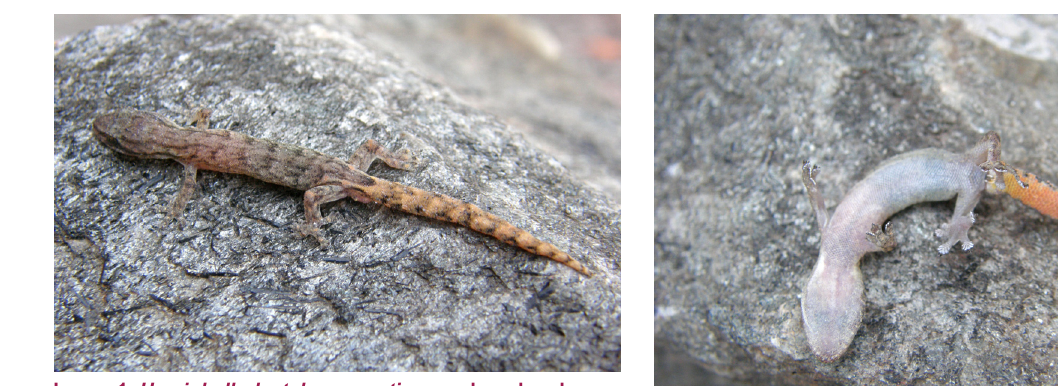
Image 1. Hemiphyllodactylus aurantiacus - dorsal and dorsolateral view Image 2. Hemiphyllodactylus aurantiacus - ventral view